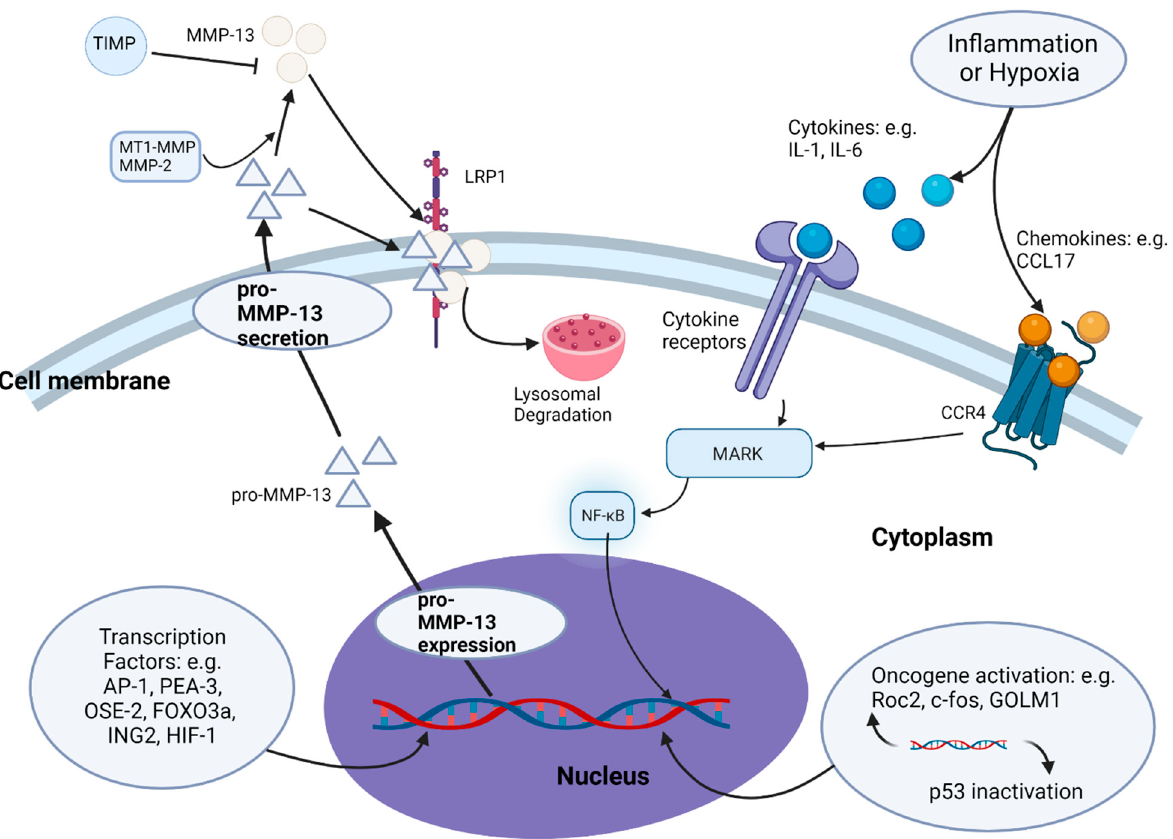
Figure 2. Regulation of MMP-13 expression and secretion in pathophysiology: MMP-13 expression and secretion in physiological conditions are tightly controlled by transcription factors and TIMPs. Various transcription factors bind directly to the MMP-13 promoter region. In cancer, the tight control of MMP-13 expression is disrupted by intrinsic and extrinsic mechanisms. Intrinsic mechanisms include changes of expression of oncogenes (e.g., Ror2) and tumour suppressor genes (e.g., p53). Extrinsic mechanisms include hypoxia and inflammation-induced secretion of cytokines and chemokines that activate downstream MARK signalling and NF- κ B nuclear translocation to regulate MMP-13 expression. MMP-13 secretion is regulated by endocytosis through endocytic receptor LRP1 and subsequent degradation in lysosomes.